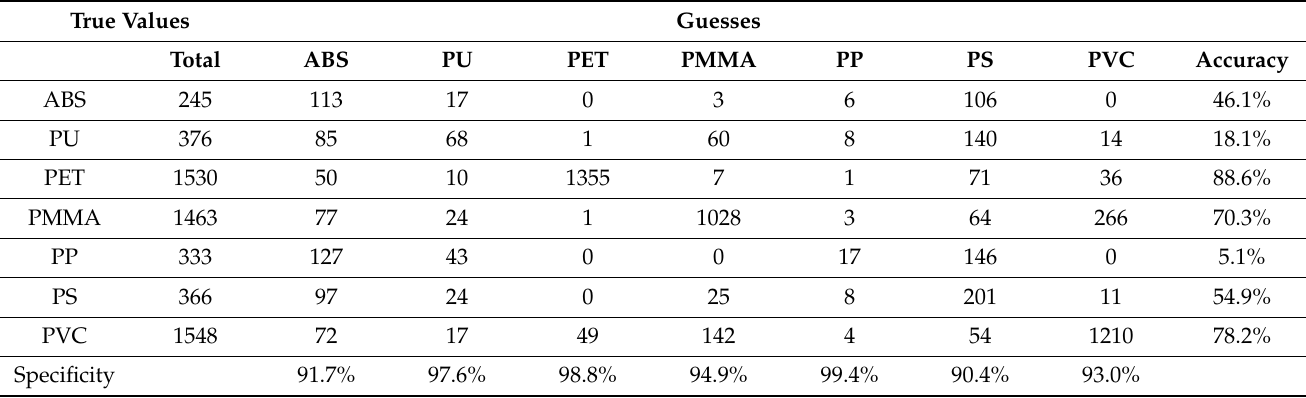
Table 1. Confusion matrix of the test data with calculated accuracy (sensitivity) and specificity of each material.